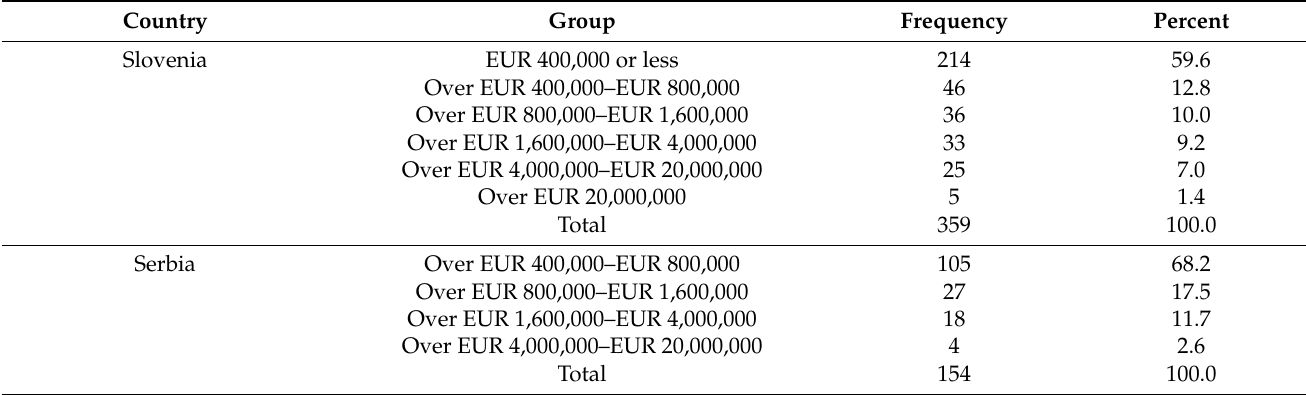
Table A5. Total sales in the last finished calendar